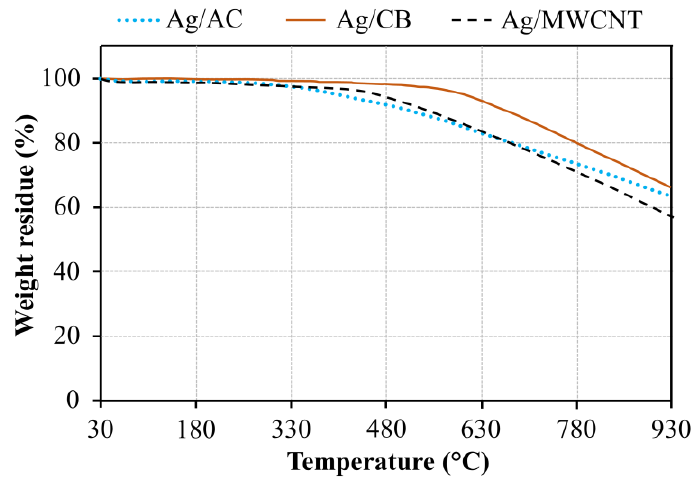
/ AC, Ag / CB, and Ag / MWCNT